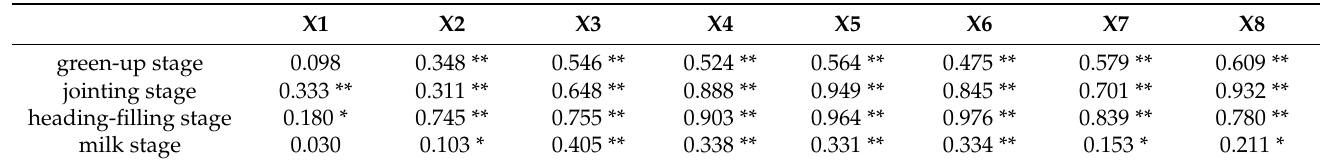
Table 3. PD values of atmospheric pressure (X1), sunshine (X2), relative humidity (X3), water vapor pressure (X4), temperature (X5), precipitation (X6), wind velocity (X7), and mean maximum temperature (X8) in different growth stages of winter wheat in rain-fed areas.